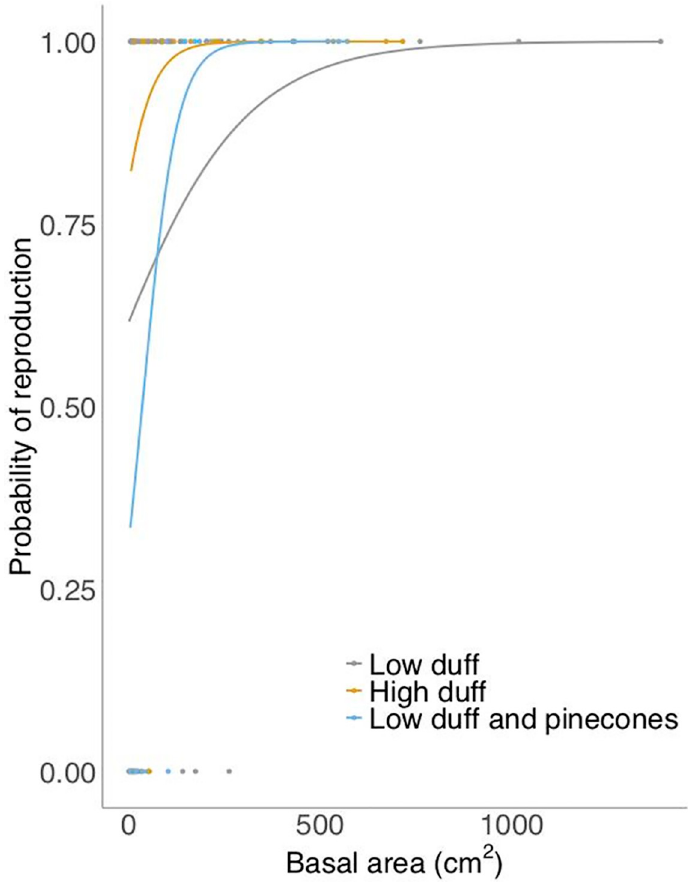
Fig 2. Probability of reproduction (inflorescence production) by wiregrass ( Aristida beyrichiana ) plants. Individuals were subject to different fuel treatments during a reintroduction fire in a long-unburned pine savanna. Probability of reproduction increased with size. There were no significant differences between individual